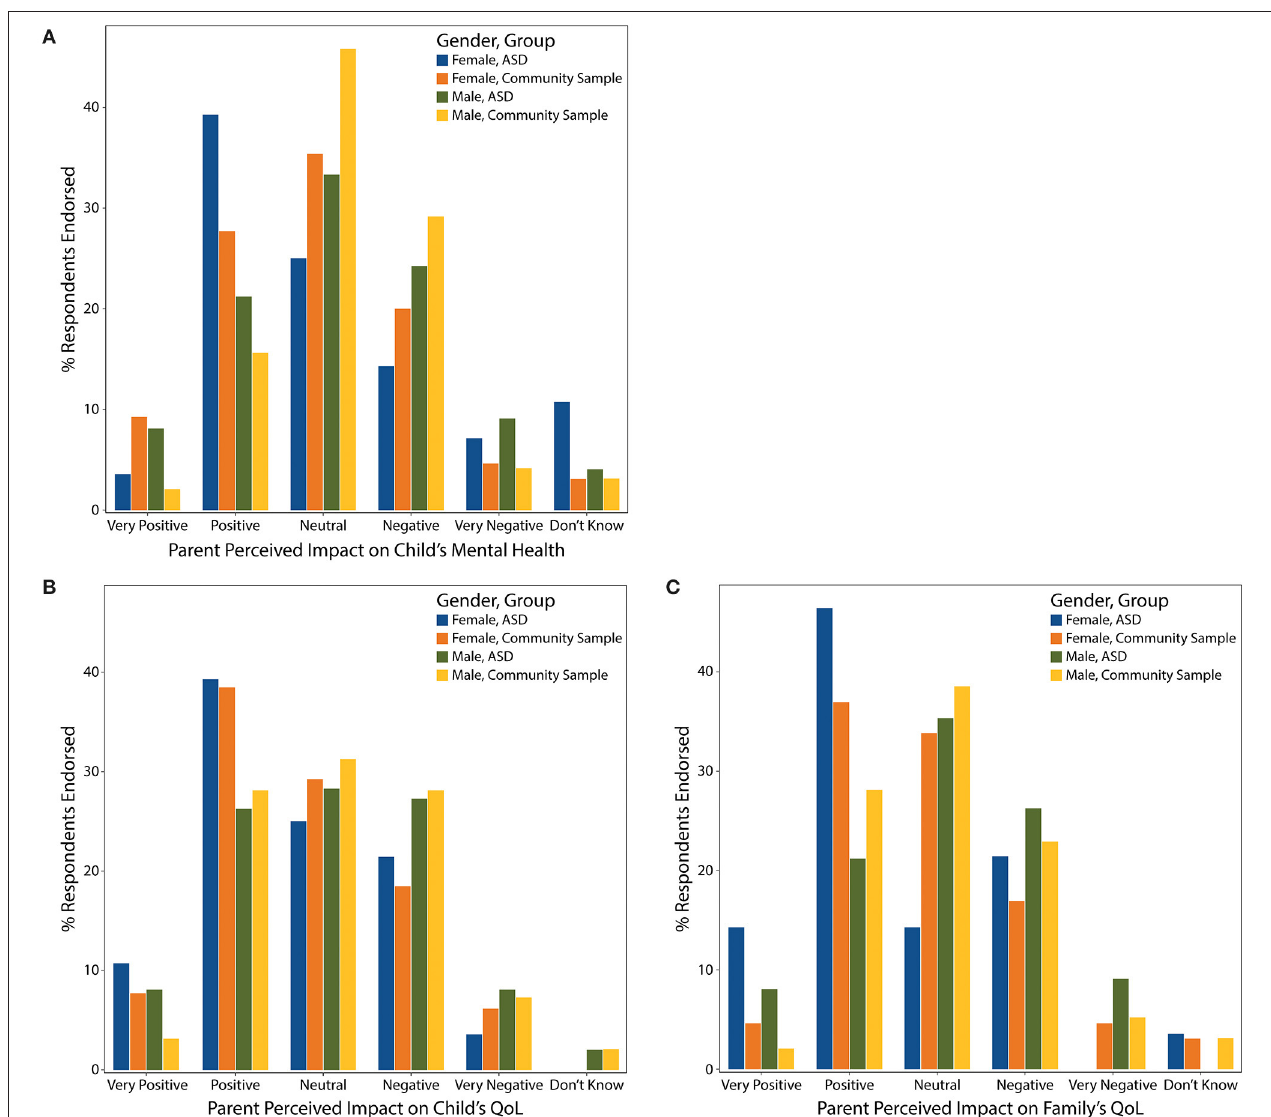
FIGURE 4 | Perceived impact of screen time on parent perceived (A) child’s mental health, (B) child’s QoL, and (C) family’s QoL displayed by gender and group.